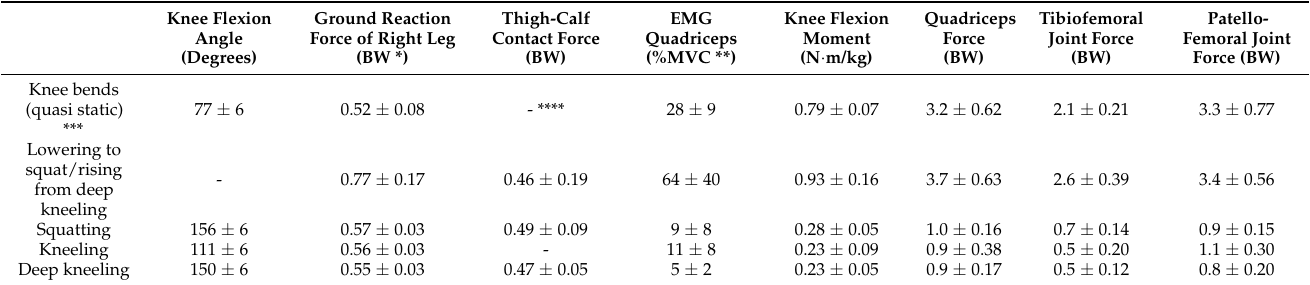
Table 1. Max external and internal loads during different activities and postures of the 13 subjects for the three repetitions (Mean ± SD).